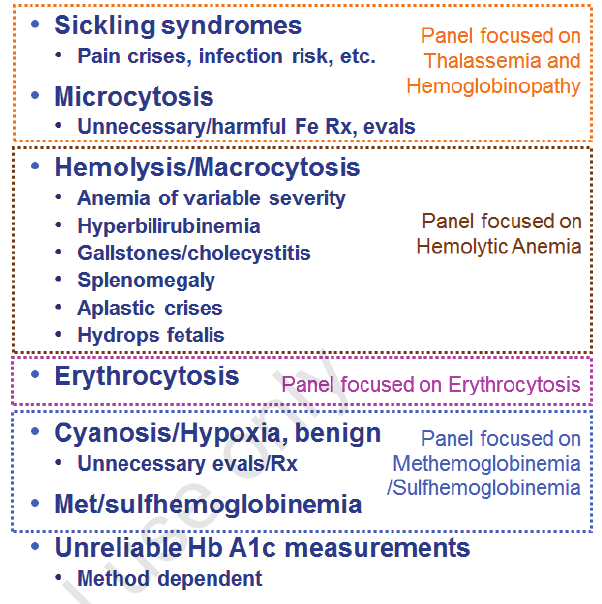
Figure 1. Hemoglobin disorders should be considered in settings other than sickling syndromes or microcytic anemia. Because hemoglobin testing includes a wide range of clinical indications ranging from monitoring of known variants, to low suspicion prenatal screening to high suspicion complex disorders, adequate communication of preanalytical data is crucial for proper and efficient testing of specimens. Creating specific assay panels based on signs and symptoms allows appropriate test utilization guided by useful algorithms.